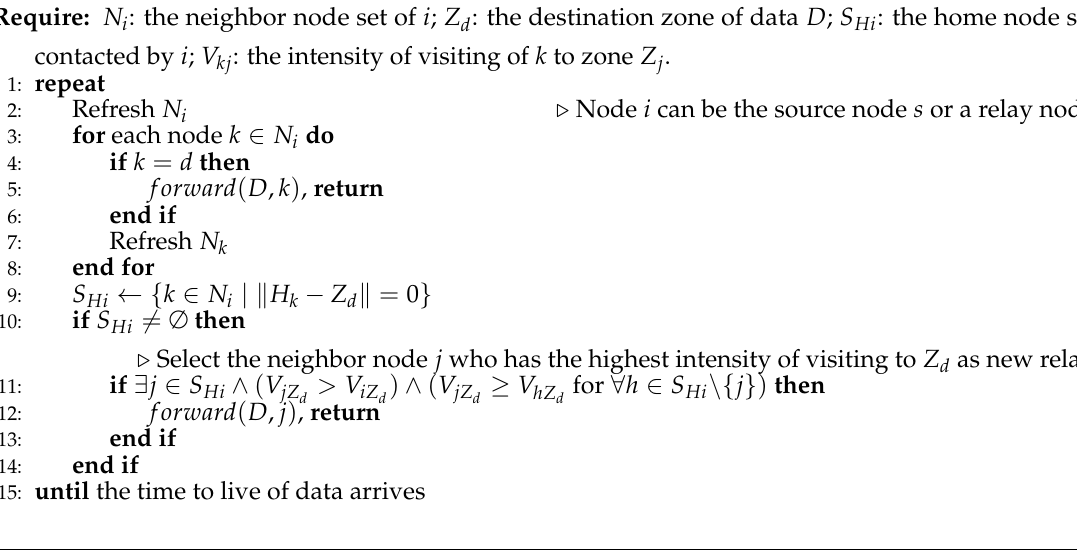
Algorithm 2 The Enhanced HERO